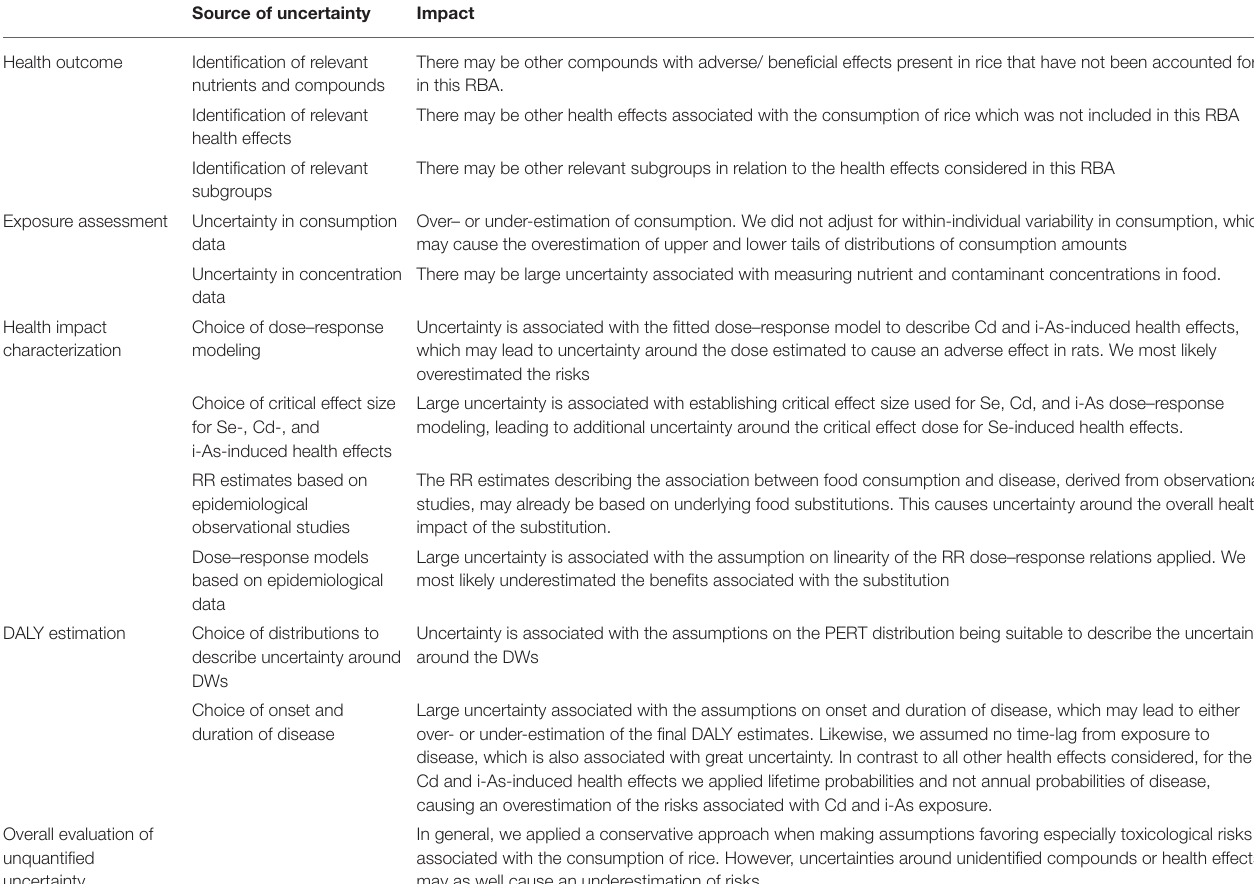
TABLE 8 | Unquantified sources of uncertainty of the final DALY difference